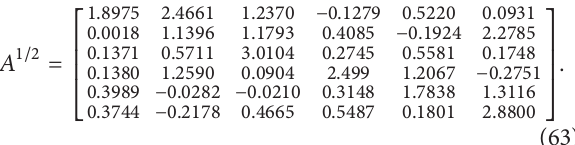
Algorithm 4( b ) does not converge to the principal square